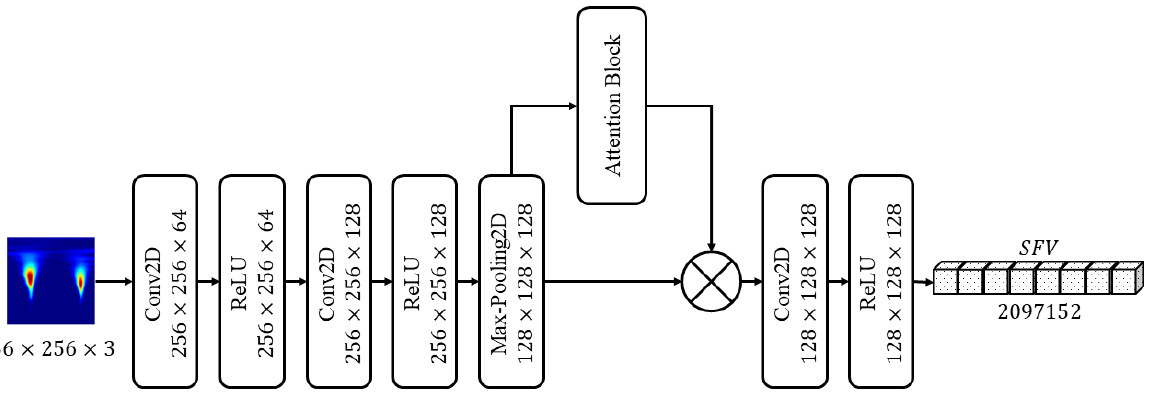
Figure 4. Proposed ArrhythmiaNet with the attention block.